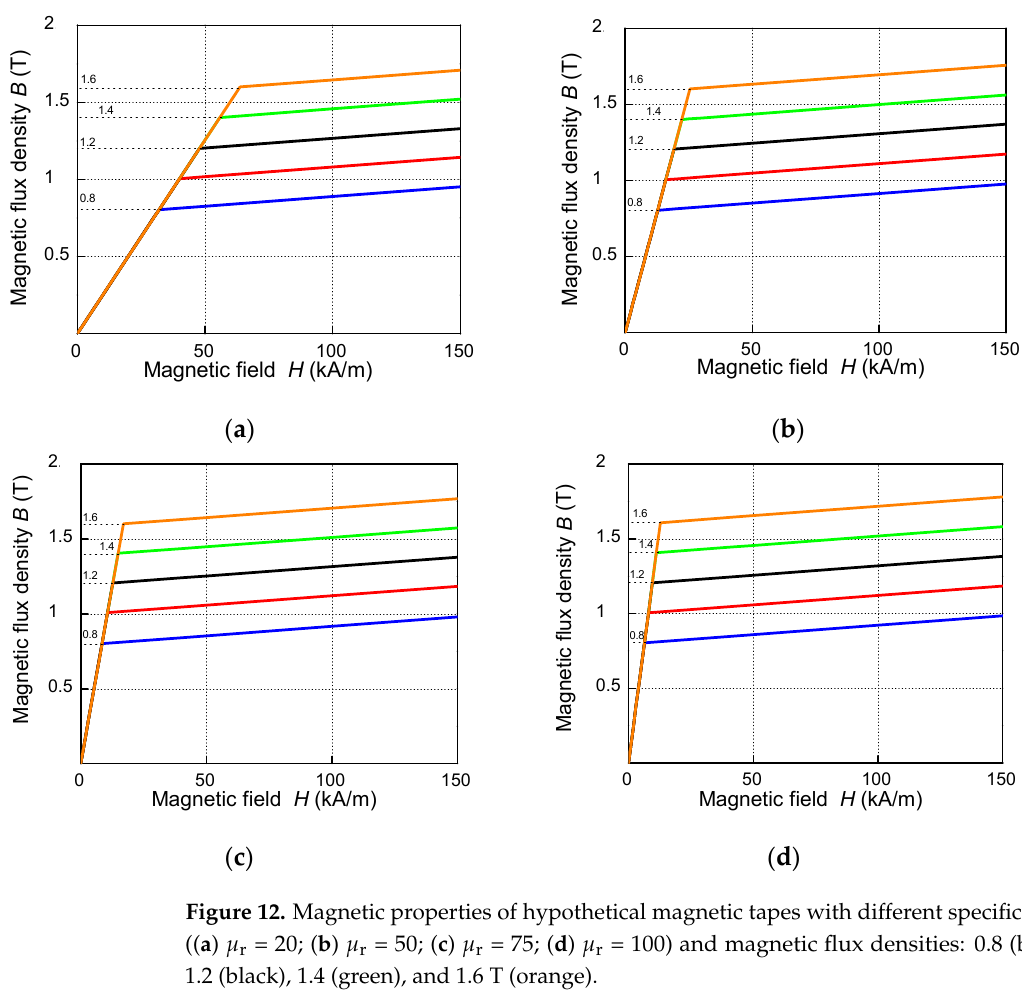
Figure 12. Magnetic properties of hypothetical magnetic tapes with different specific permeabilities (( a ) μ r = 20; ( b ) μ r = 50; ( c ) μ r = 75; ( d ) μ r = 100) and magnetic flux densities: 0.8 (blue), 1.0 (red), 1.2 (black), 1.4 (green), and 1.6 T (orange).